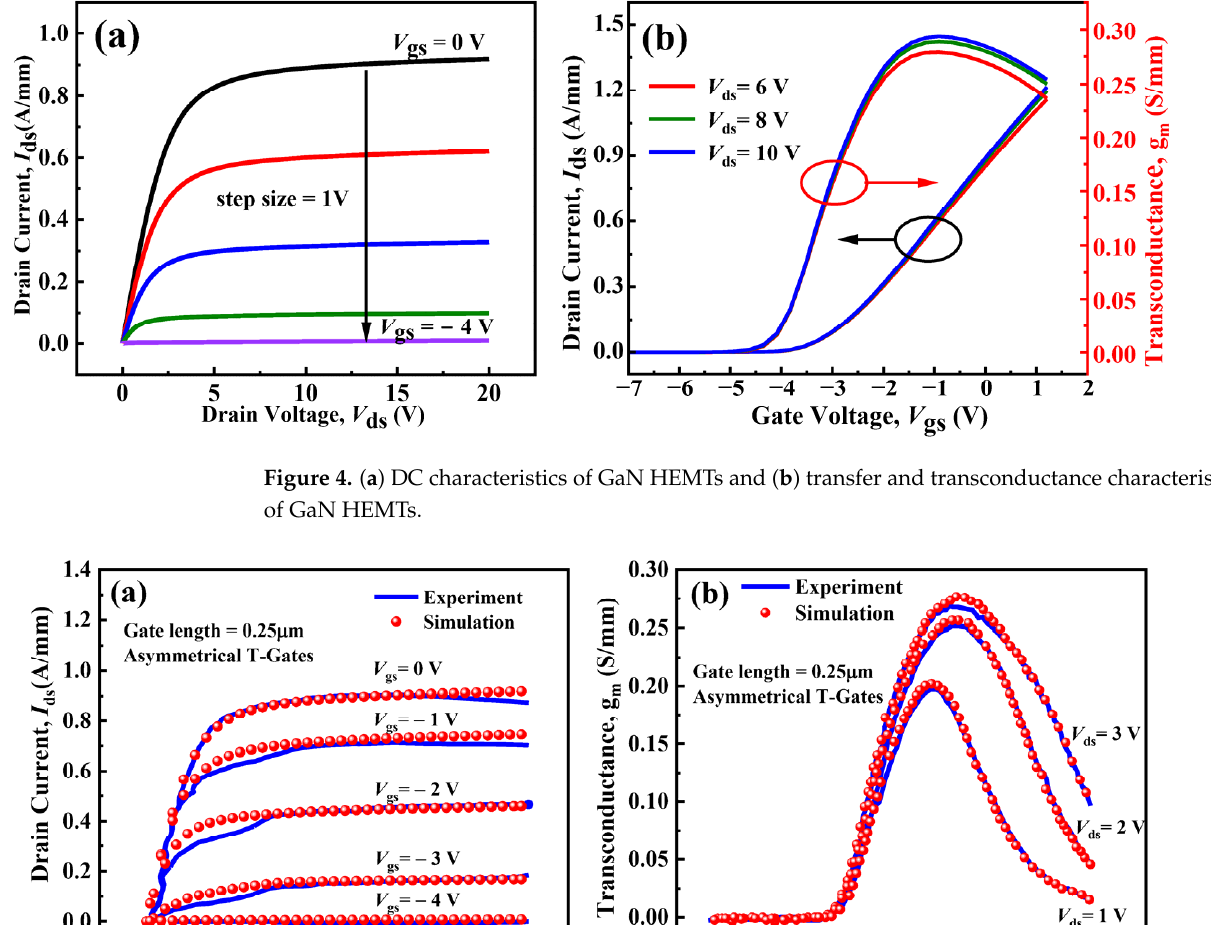
Figure 3. ( a ) Band diagram illustrating simulated trap details. ( b ) Energy band edge (black and blue lines) and electron density (red line) in the vicinity of the channel.